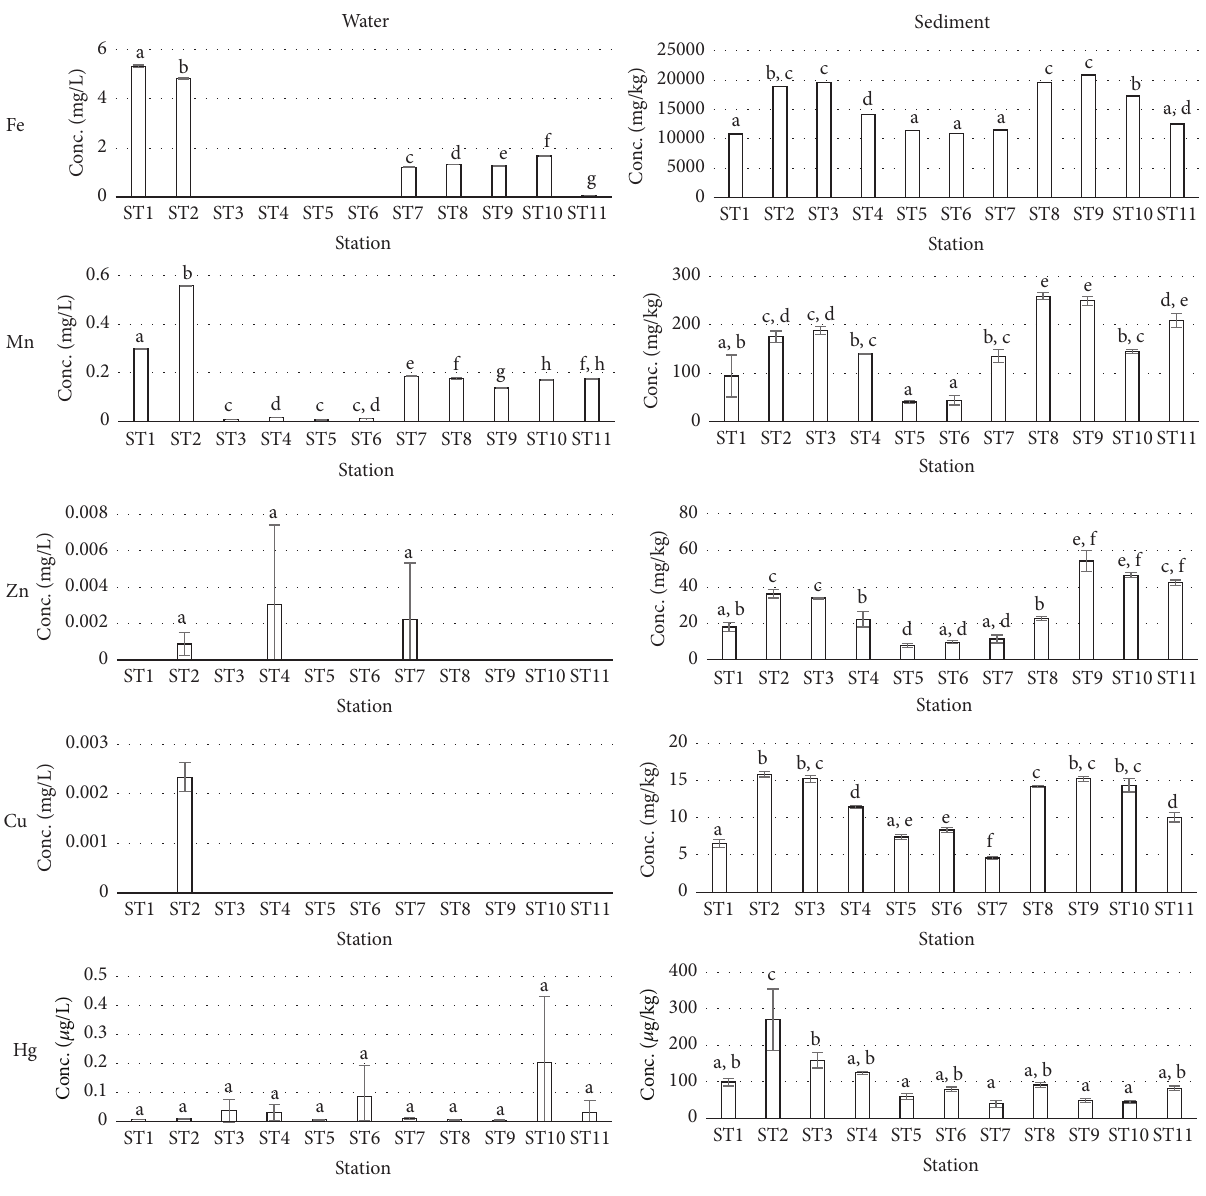
to the reservoir. The declining concentration at the dam wall is possibly associated with the reaerated